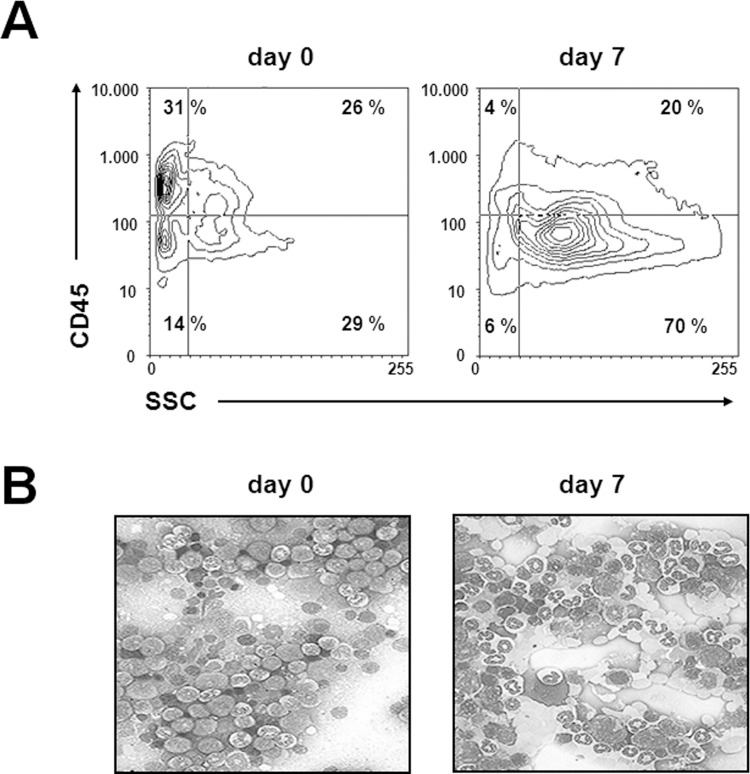
Effects of anti-RT7a mAb on bone marrow level.A single dosage of 10 mg/kg of anti-RT7a was injected into LEW.1W rats (n = 4). (A) BMC were analysed 7 days after mAb injection, whereby BMC were categorized by CD45 expression density and granularity using flow cytometry. Myelopoiesis showed a right shift, whereby SSClow/CD45low early progenitors as well as SSClow/CD45high lymphoid progenitors were markedly reduced. (B) Histology verified the right shift in myelopoiesis.